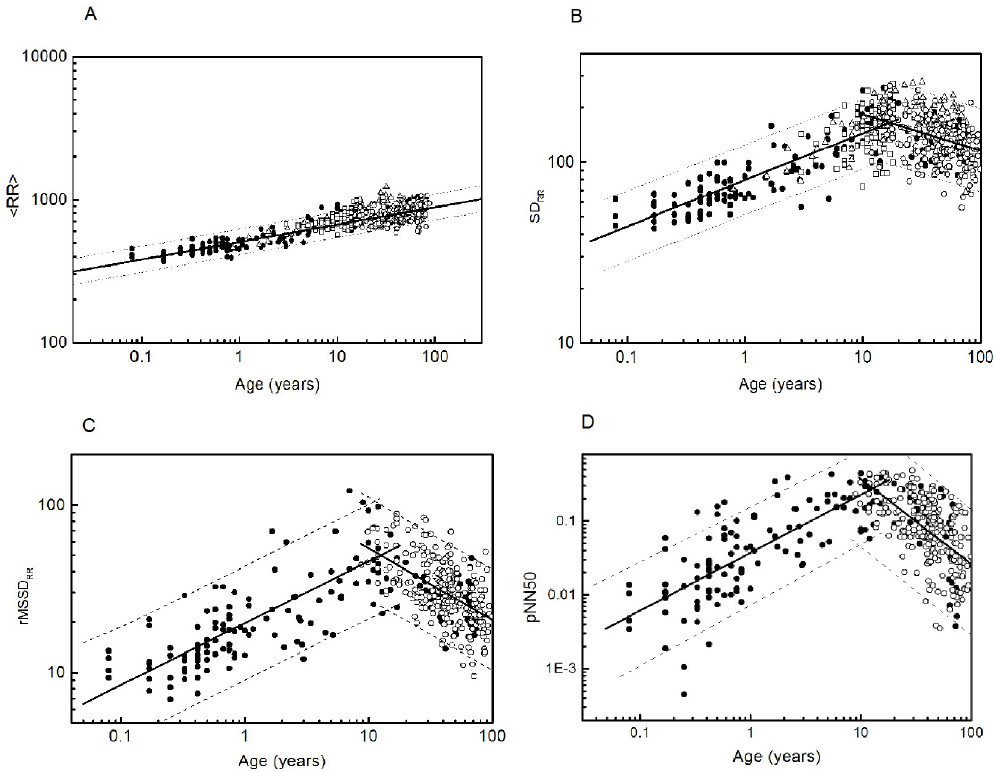
Fig 1. Age dependence of some time-domain indices: (A) < RR > , (B) SD RR , (C) rMSSD RR , (D) pNN 50 Filled circles correspond to data obtained in this work, open squares to data from [2], open circles to data from [33], and open triangles to data from [34]. Dashed lines indicate the 95% prediction